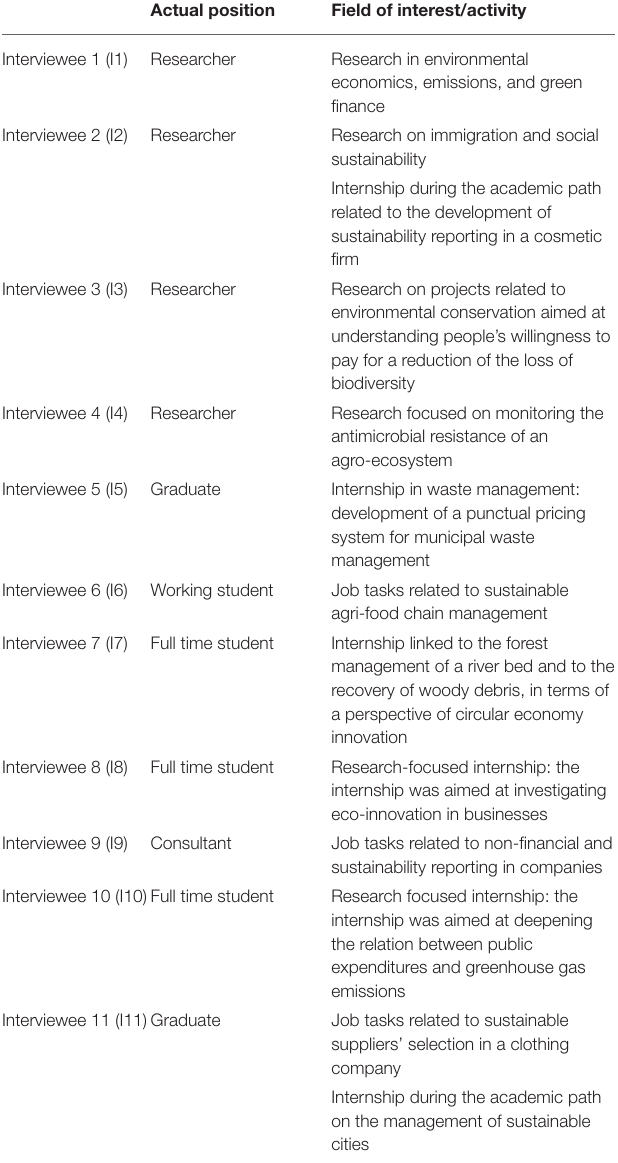
TABLE 1 | The characteristics of the